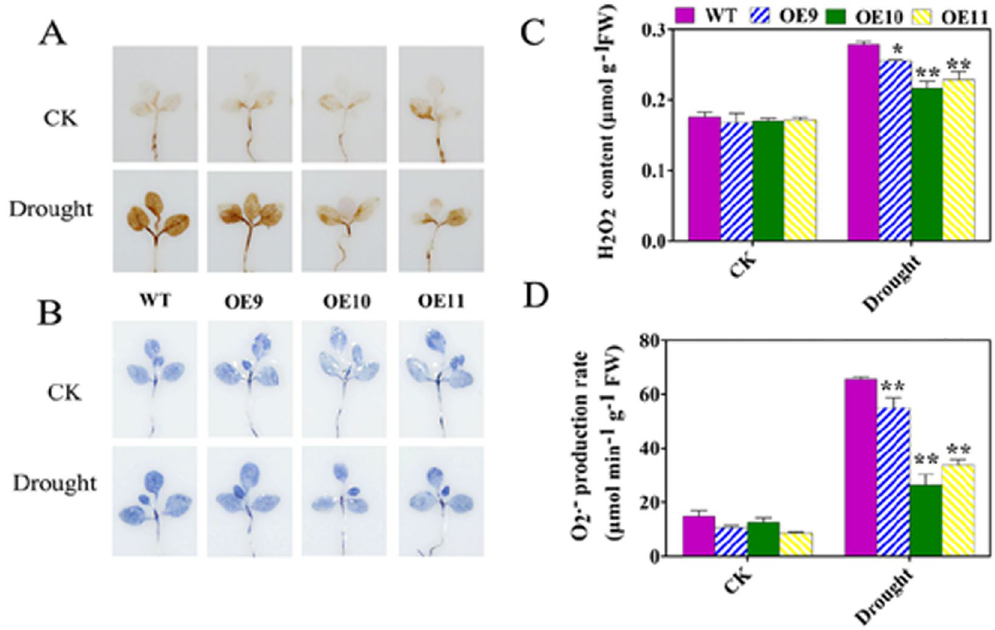
Figure 6. Influence of drought stress on ROS accumulation in the OE and WT plants. In situ detection of H 2 O 2 ( A ) and ⋅− O ( B ) by DAB and NBT staining, respectively, in TaPUB1 overexpression and WT seedlings grown on 2 roseite medium for two weeks and treated with 100 mM mannitol, thereafter, for 7 d. (C) H 2 O 2 content and (D) ⋅− O production rate. The experiments were repeated three times and the bars indicate SEs. * and ** indicate 2 significant differences at P < 0.05 and P < 0.01 among the three overexpression lines and the WT